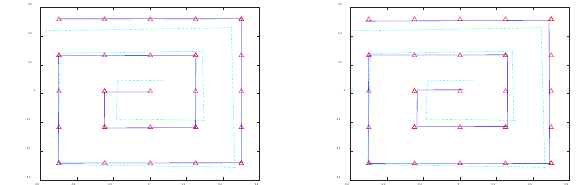
Figure 3: Estimated trajectory using GP-SLAM with different true l . (Left) l = 0.1m, and (Right) l = 0.4m. The cyan dash line shows the odometry only solution, the blue solid line indicates the GP-SLAM solution, and the red triangles are the ground truth.